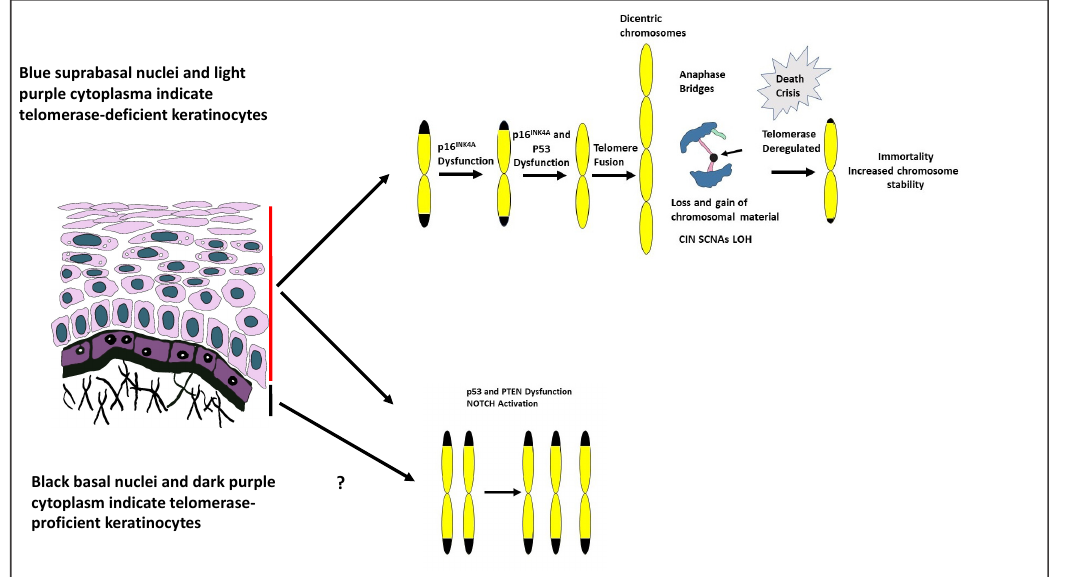
Figure 1. Possible sources of CIN, SCNA and LOH in squamous epithelium. The schematic of squamous epithelium takes into account the many reports that telomerase activity is confined to the proliferative compartment of the tissue and that telomere attrition is minimal in normal tissue. The suprabasal keratinocytes (blue nuclei, light purple cytoplasm) are telomerase-deficient, whereas the basal keratinocytes (black nuclei, dark purple cytoplasm) have sufficient telomerase activity to largely suppress telomere attrition and genomic instability; the latter occurs via chromosome end fusions (fusion–bridge–breakage cycles). It is proposed that neoplastic lesions evolve and progress from telomerase-deficient suprabasal cells and generate SCNA during cellular crisis, prior to immortalization and telomerase de-regulation. Implicit to this process are the end-to-end fusion of chromosomes and the formation of anaphase bridges. In anaphase bridges that link anaphase plates (dark blue), the arrow indicates the fused chromosome ends (black). CIN, chromosome instability; SCNA, somatic copy number alterations; LOH, loss of